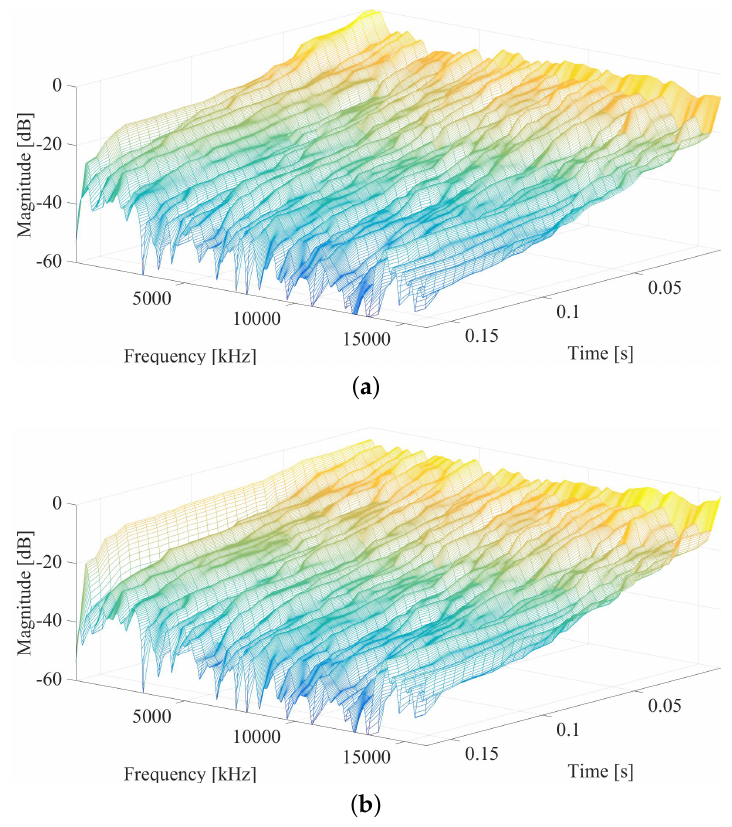
Figure 13. EDR results: ( a ) without equalization; ( b ) after